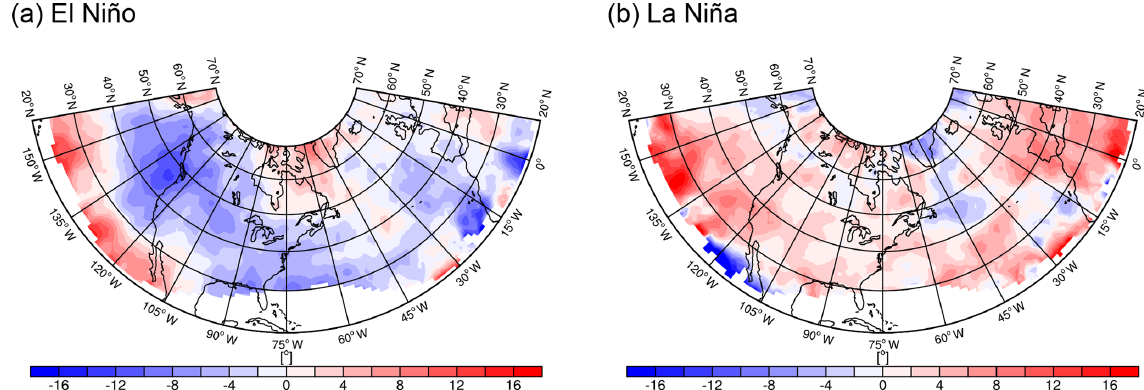
Figure 6. Averaged orientation anomalies (units: degrees) of 500hPa troughs and ridges during (a) El Niño- and (b) La Niña-affected winter seasons. Negative (positive) anomalies indicate more cyclonically (anticyclonically) oriented troughs and ridges compared to the seasonal climatology. Regions where the detection frequency is below 2% are